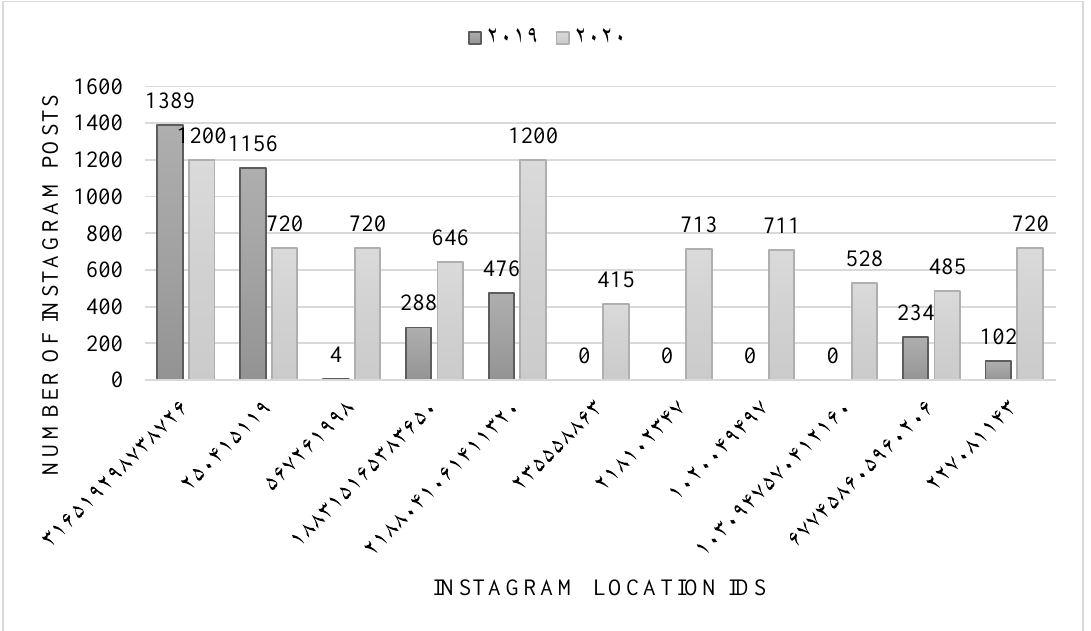
Figure 8 Number of Instagram posts in each location